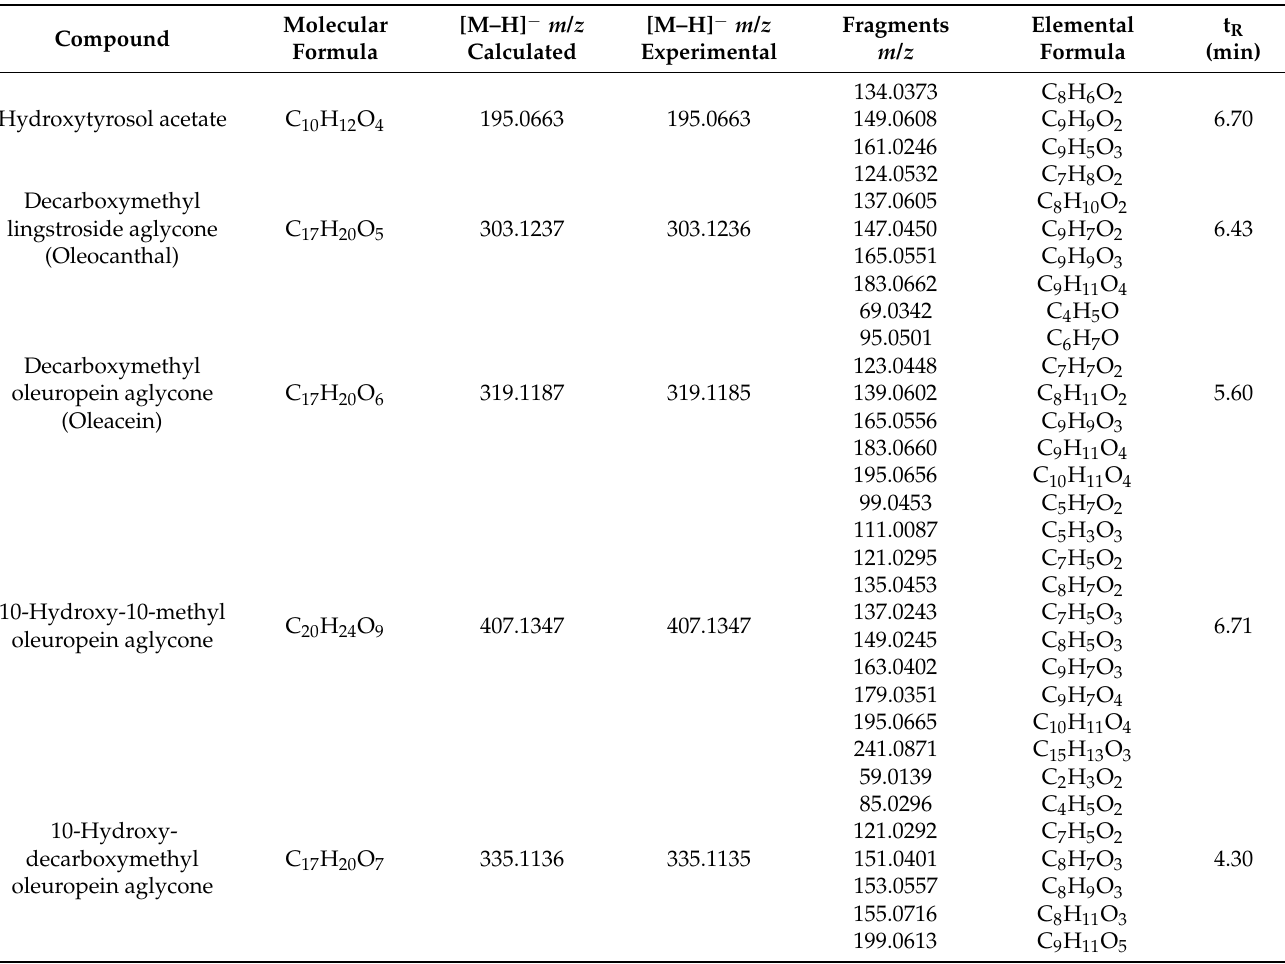
Table 2. Suspect screening